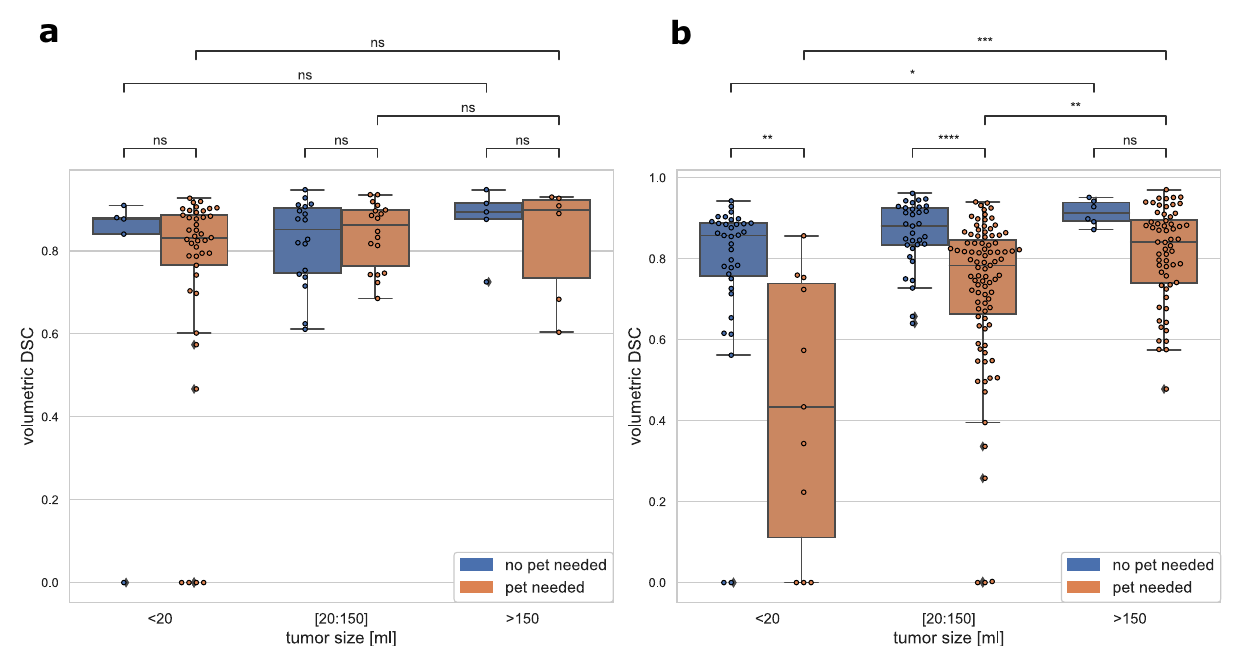
Fig. 2 Quantitative performance with regards to tumor size and complexity. Quantitative performance is measured in volumetric dice similarity coef fi cient (DSC). Tumor complexity is de fi ned through the necessity of using PET to produce segmentation. Data were presented as box plots with overlaid swarm plots, where boxes are representing the interquartile range (IQR), extending from Q1 to Q3 and centered on the median value. Upper whiskers represent the highest data point that is less than Q3 + 1.5 × IQR. Lower whiskers represent the smallest data point that is greater than Q1 − 1.5 × IQR. Data points outside whiskers are considered as outliers. P values were calculated using a two-sided Mann – Whitney – Wilcoxon test with Bonferroni correction and referred as follows: “ ns ” on the plot refers to the p value in the range: 5.00e-02 < p ≤ 1.00e + 00; *refers to the p value in the range: 1.00e-02 < p ≤ 5.00e-02; **refers to the p value in the range: 1.00e-03 < p ≤ 1.00e-02; ***refers to the p value in the range: 1.00e-04< p ≤ 1.00e- 03; ****refers to the p value in the range: p ≤ 1.00e-04. The exact p values are reported in the order from left to right and from the top to the bottom as they are displayed on the fi gures. Calculations provided for: a the test dataset of 93 independent NSCLC CT scans, corresponding p values are: 1.000e + 00, 1.000e + 00, 1.000e + 00, 1.000e + 00, 1.000e + 00, and 1.000e + 00; b the external validation dataset of 236 independent NSCLC CT scans, corresponding p values are: 4.120e-04, 4.022e-02, 8.471e-03, 2.259e-03, 1.662e-05, and